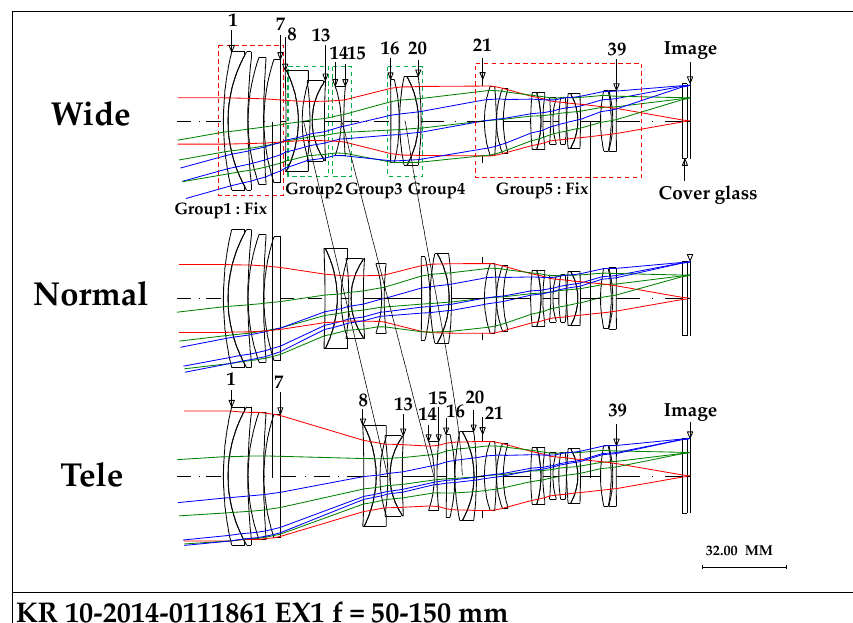
Figure 10. Optical layout of the first example in KR-2014-0111861 [17]. Table 10. Padé approximation linearization of the second lens group for the optical system shown in Figure 10.